Question: Write a single sentence explaining what this figure depicts.
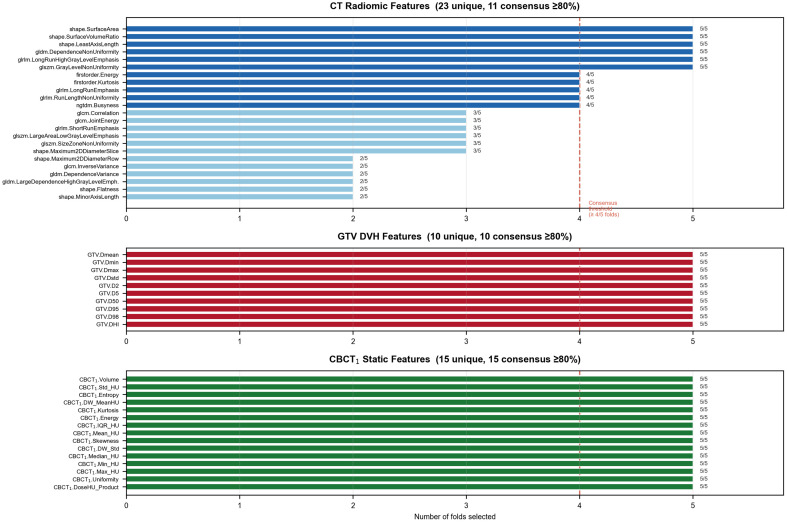
Answer: Cross-fold feature selection stability for the primary 45-dimensional input. Horizontal bars indicate the number of folds (out of 5) in which each feature was retained by the within-fold feature-selection pipeline. The dashed red line marks the 80% consensus threshold (≥4/5 folds). CT radiomic features show moderate variability after within-fold pruning and ANOVA ranking, whereas the 10 GTV DVH features and 15 CBCT 1 static features were consistently retained as compact modality-specific inputs.